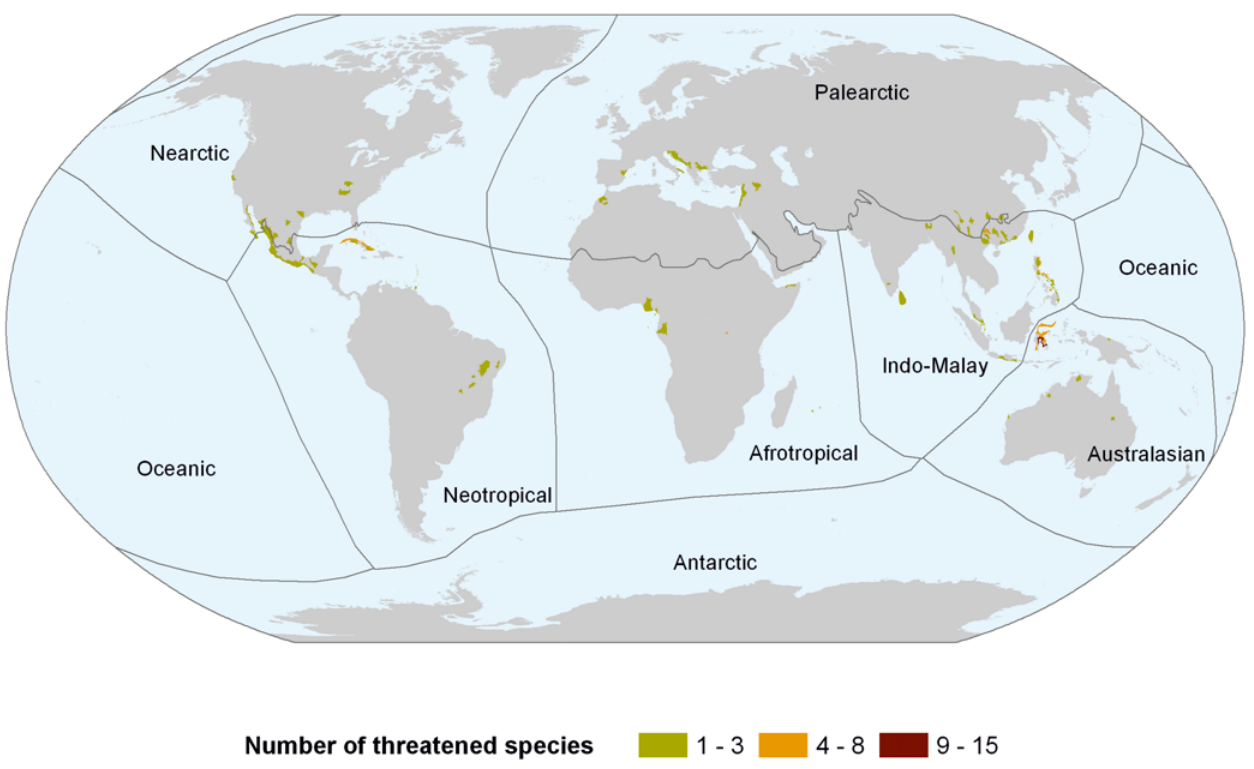
Fig 6. Global distribution of threatened freshwater shrimp